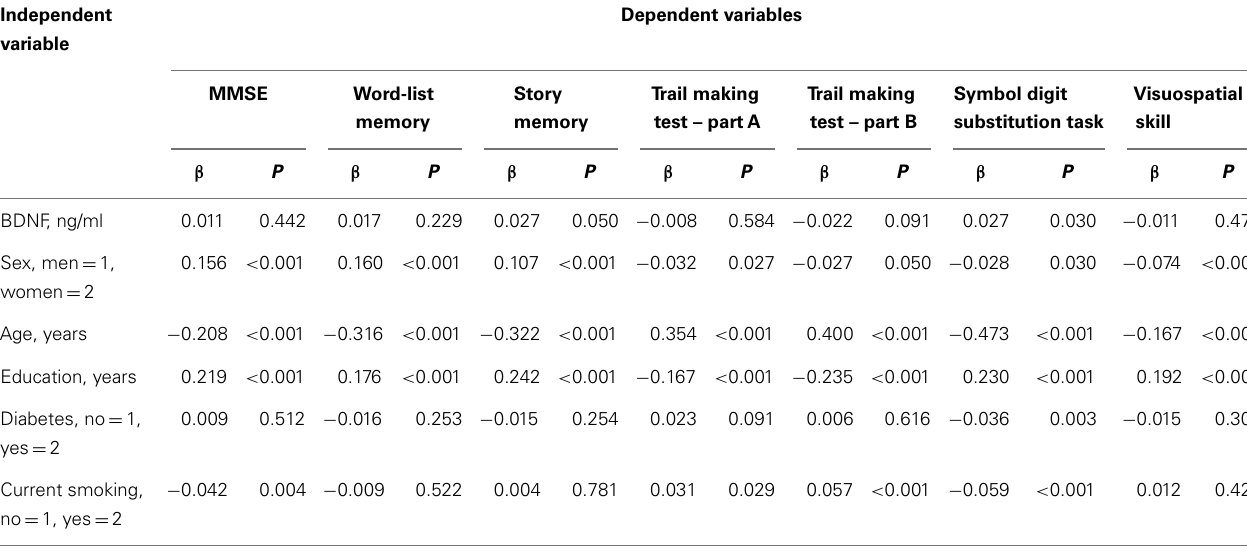
Table 4 | Relationships between MCI and BDNF or selected correlates.